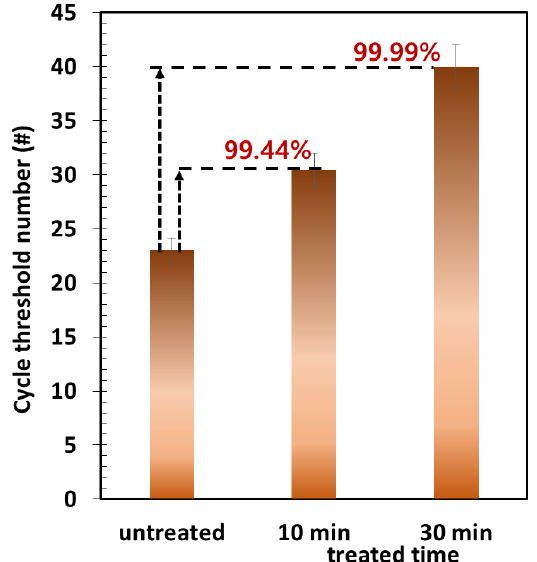
Figure 9. Electrothermal antiviral activity of the carbon surface against H1N1 viruses via a PCR system.